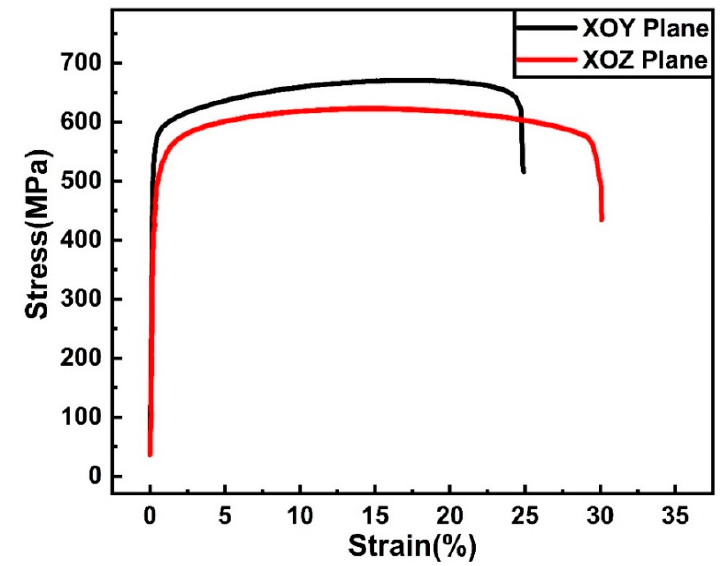
Figure 7. Tensile engineering stress–strain curves of the SLM processed CoCrFeMnNi alloy. Table 3. Tensile properties of CoCrFeMnNi alloy at room temperature. Table 3. Tensile properties of CoCrFeMnNi alloy at room